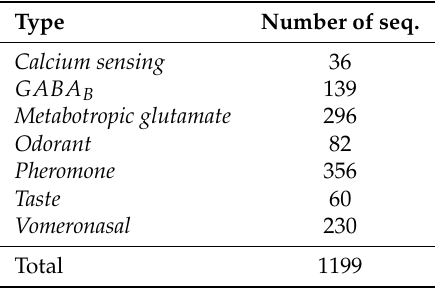
Table 2. Distribution of the aligned class C GPCRs.